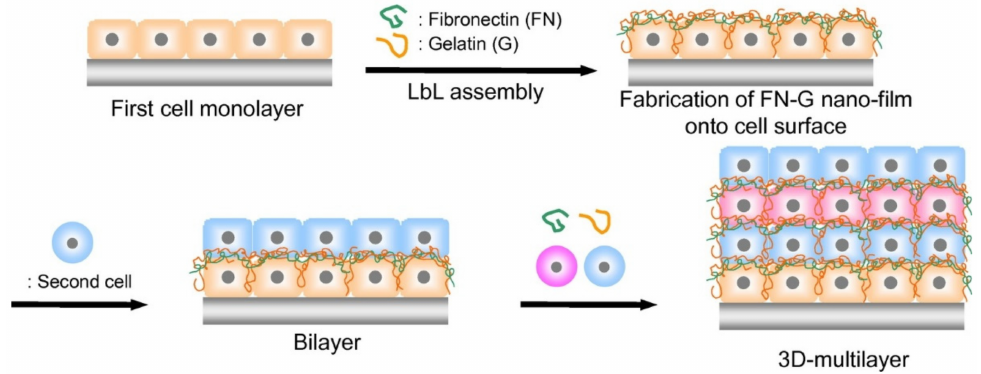
Figure 8. Three-dimensional nanoarchitectonics of living cells through their LbL assembly with the aid of fibronectin and gelatin. Reprinted with permission from Reference [132]. Copyright 2021 Chemical Society of